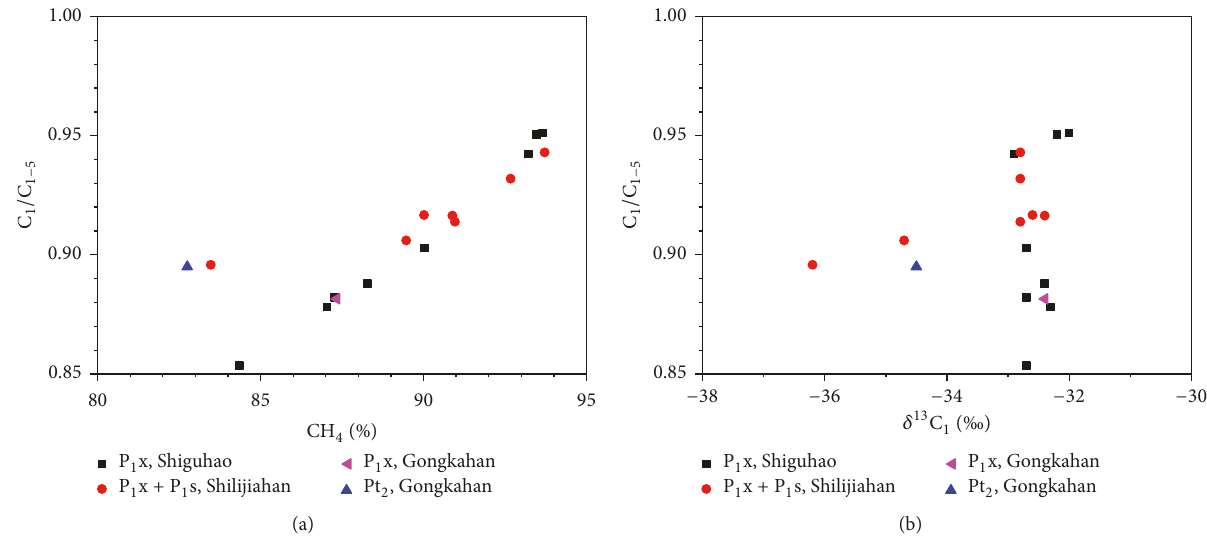
) versus CH 4 % (a) and C 1 /C 1 ratio versus 𝛿 13 C 1 value (b) of tight gas from – 5 – 5